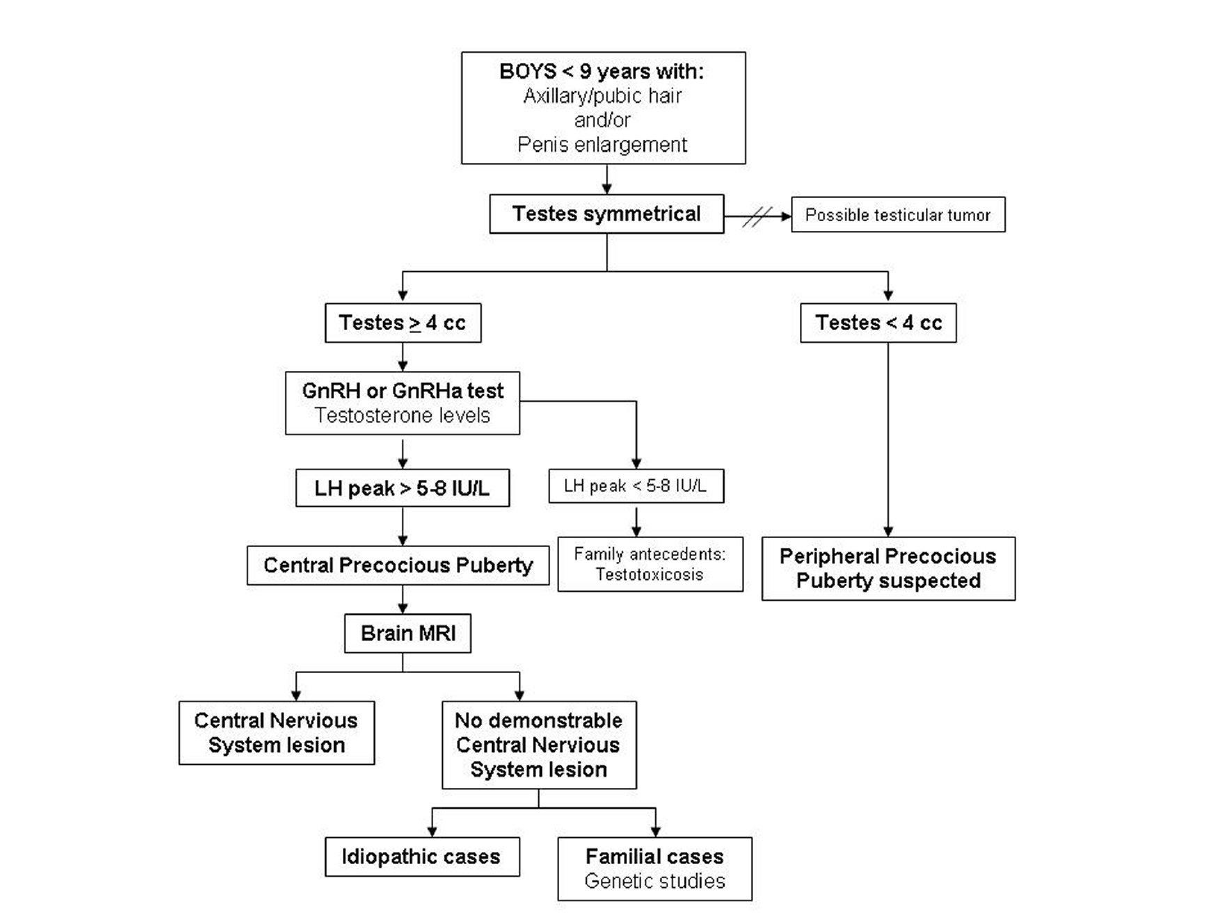
Figure 2 : Diagnostic algorithm of CPP in